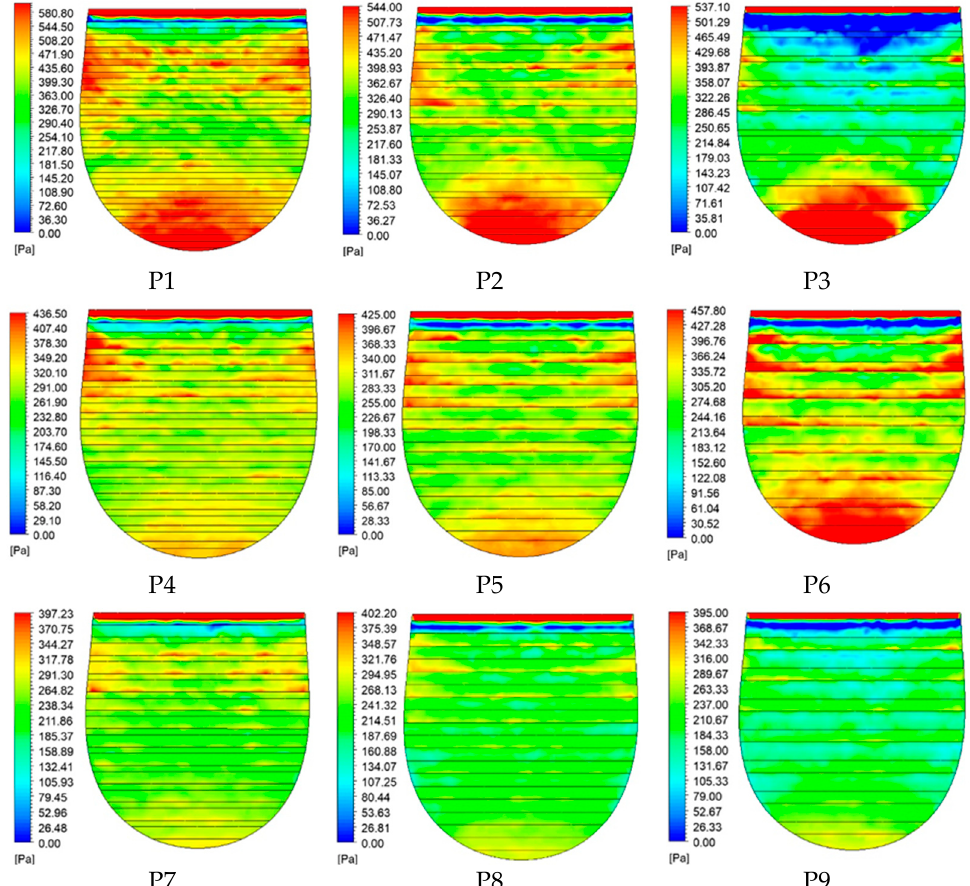
Figure 7. Induced fluid pressures over the outsoles simulated in the presence of water as